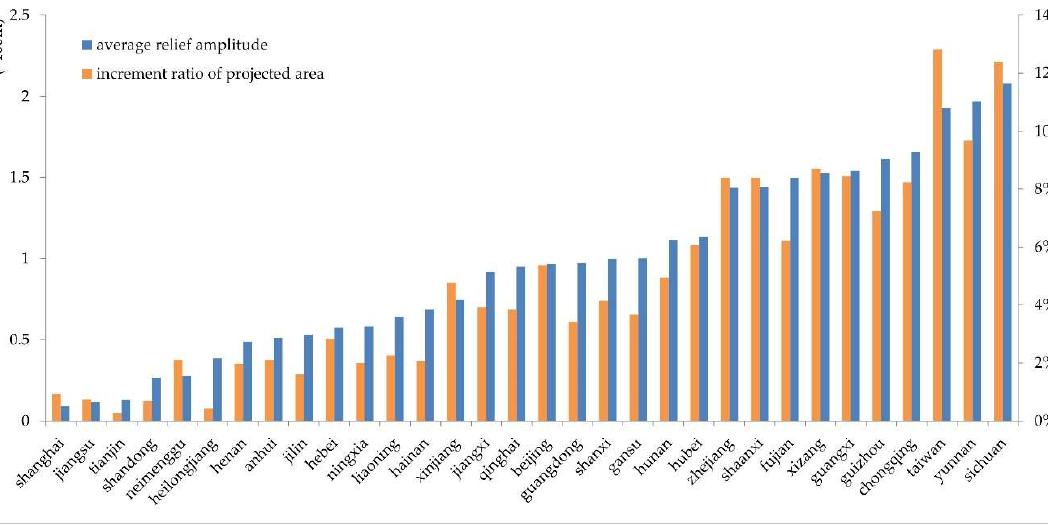
Figure 10. Comparison of the increment ratios of the projected area and average relief amplitude.